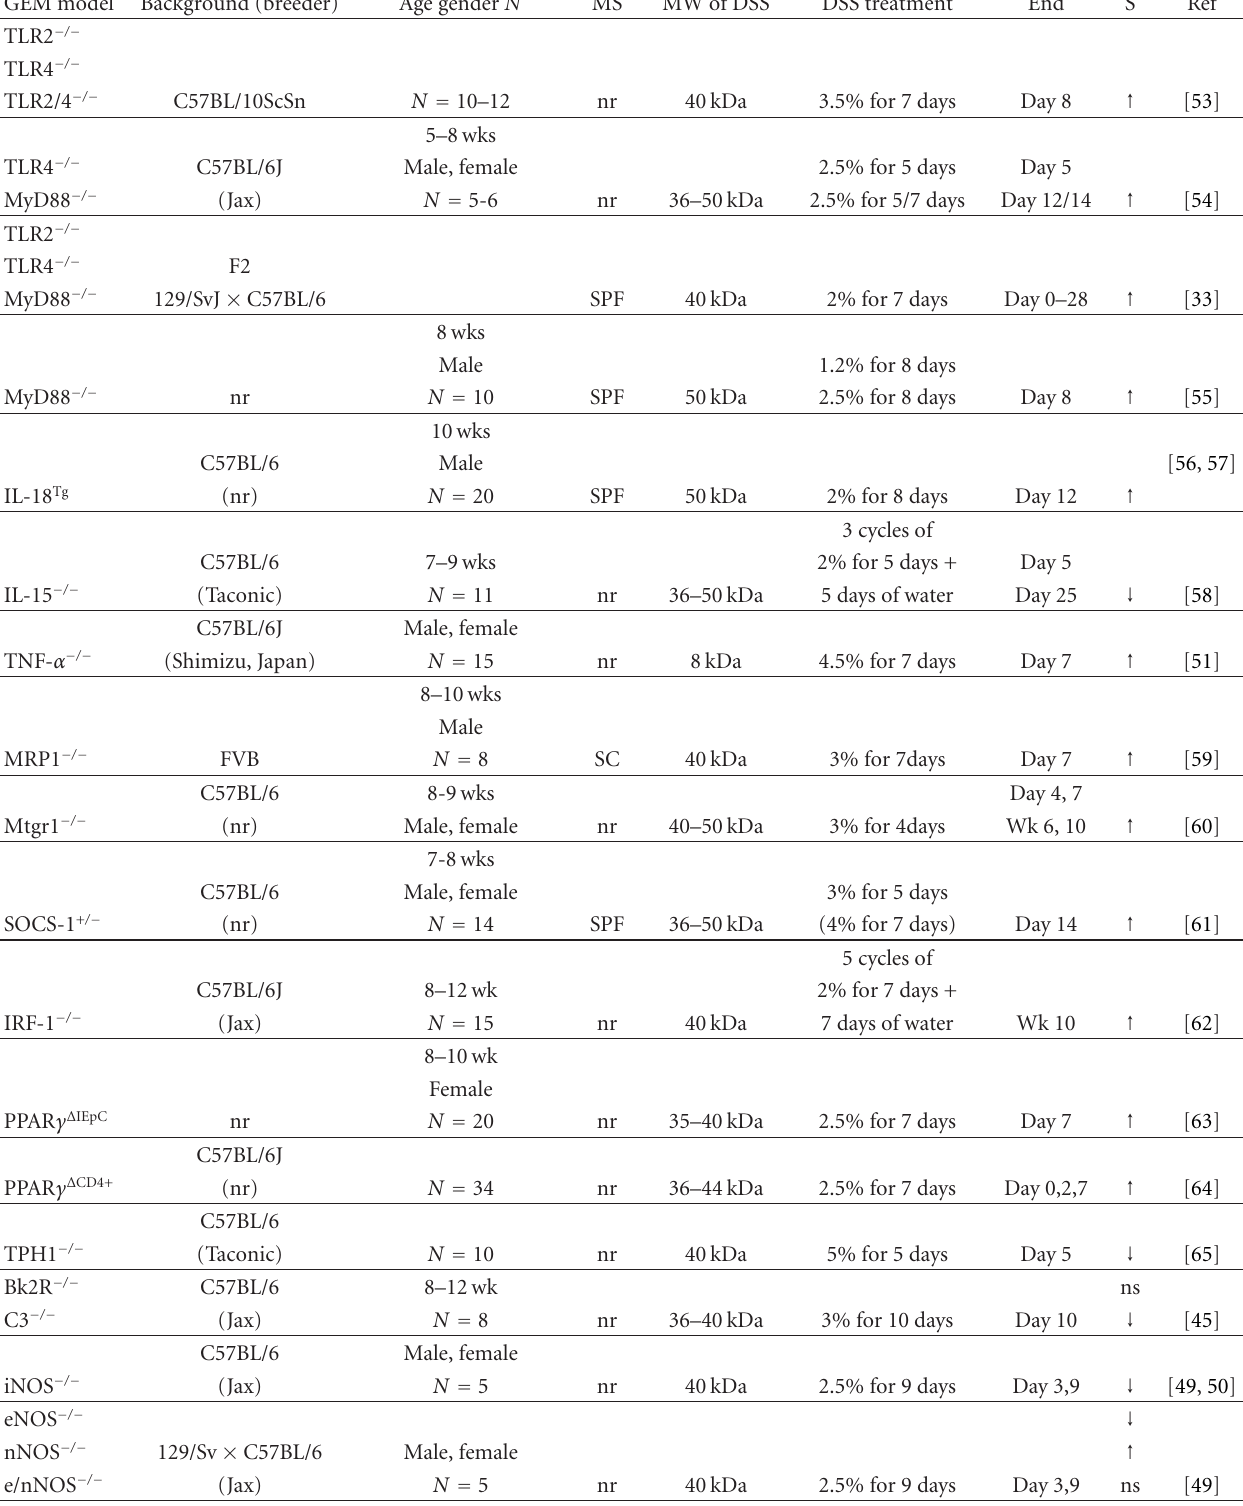
Table 4: Genetically engineered mouse models in the pathogenesis of DSS